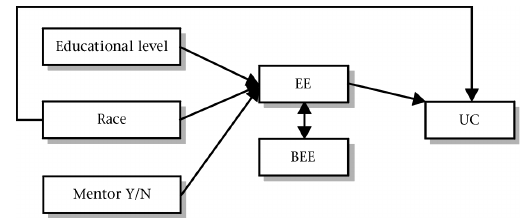
Figure 14: Results of a predictive model for union commitment